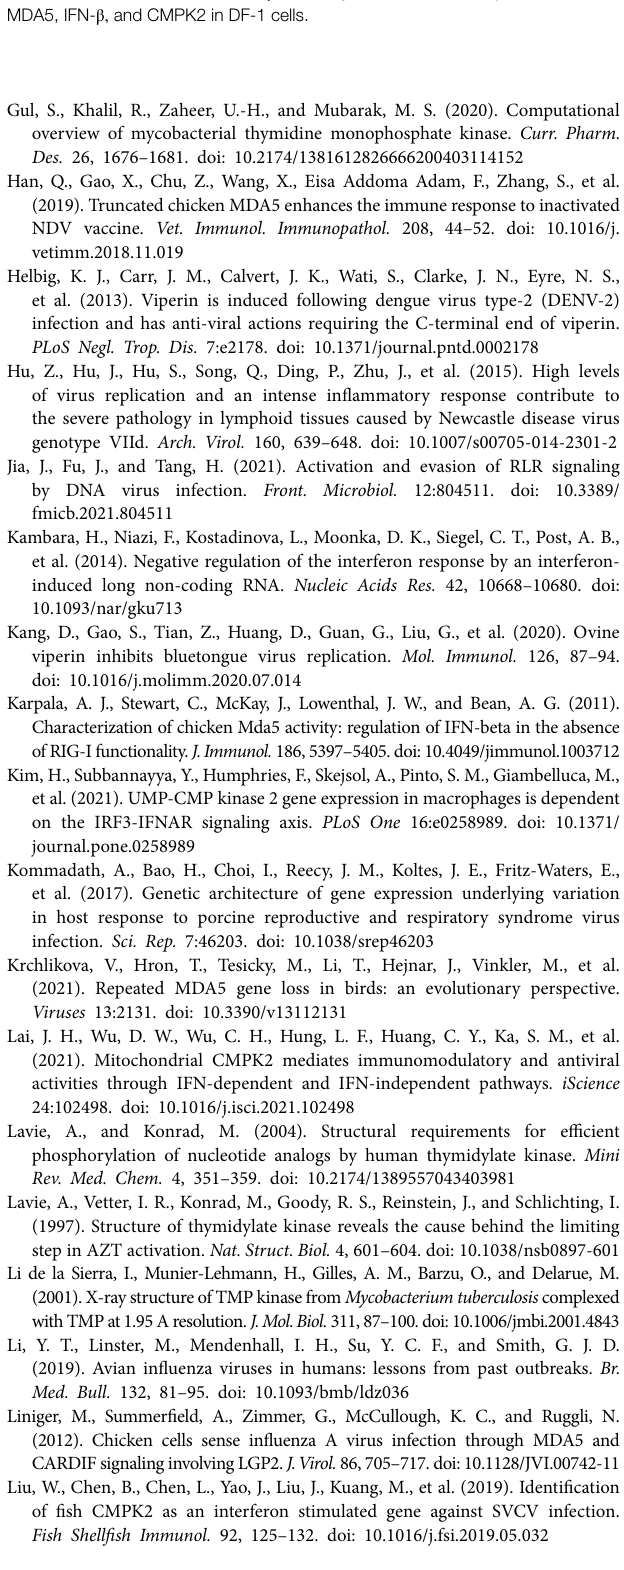
SUPPLEMENTARY TABLE S3 | The siRNA used in this